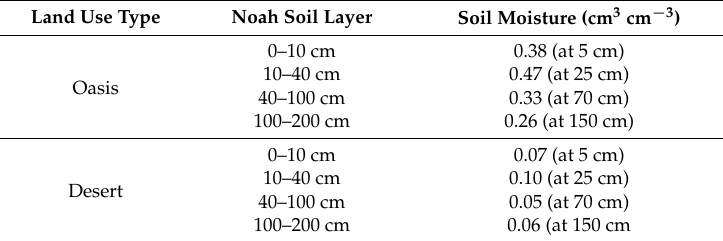
Table 2. Soil moisture values for the oasis and desert areas in the four Noah soil layers